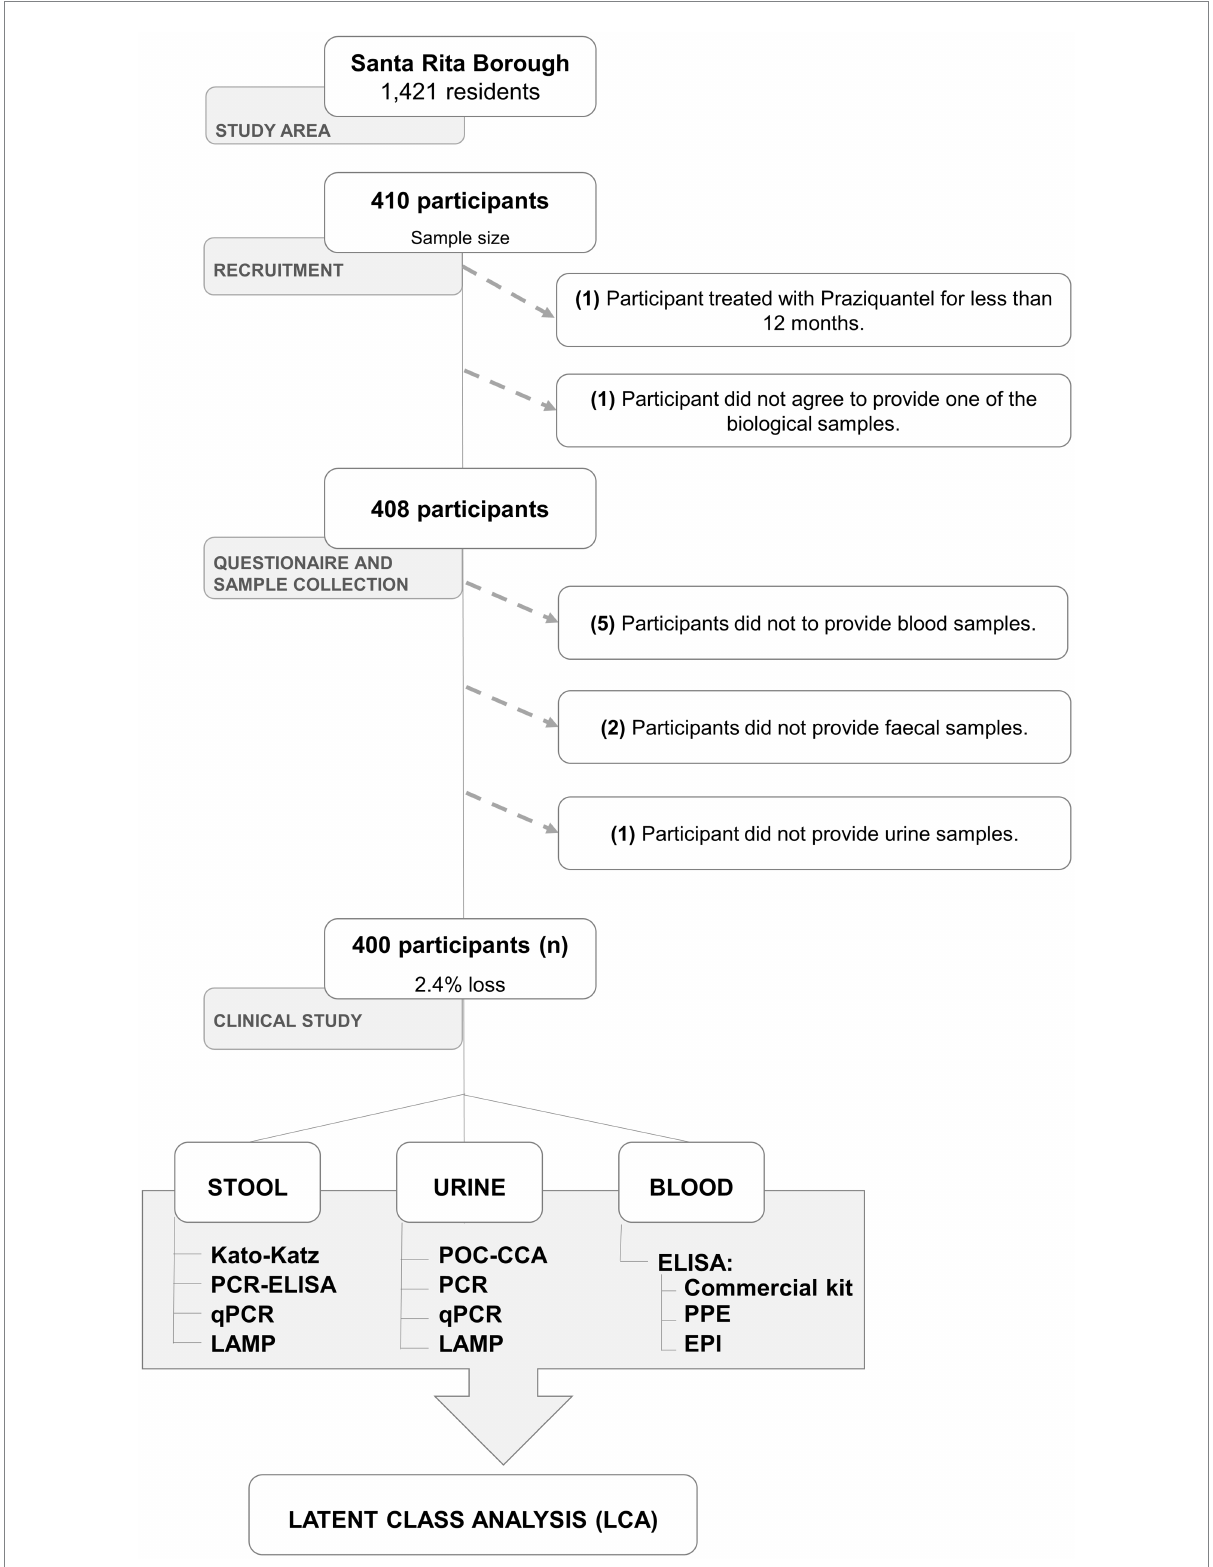
FIGURE 1 Flowchart detailing the study design. Legend: PCR-ELISA = polymerase chain reaction coupled with the enzyme-linked immunosorbent assay; qPCR = quantitative real-time PCR; LAMP = loop-mediated isothermal amplification; POC-CCA = point-of-care circulating cathodic antigens; Commercial kit = anti- Schistosoma-mansoni IgG commercial ELISA kit from Euroimmun; PPE = in-house anti-IgG ELISA test using the recombinant antigen PPE; EPI = in-house anti-IgG ELISA test using the Smp150390.1